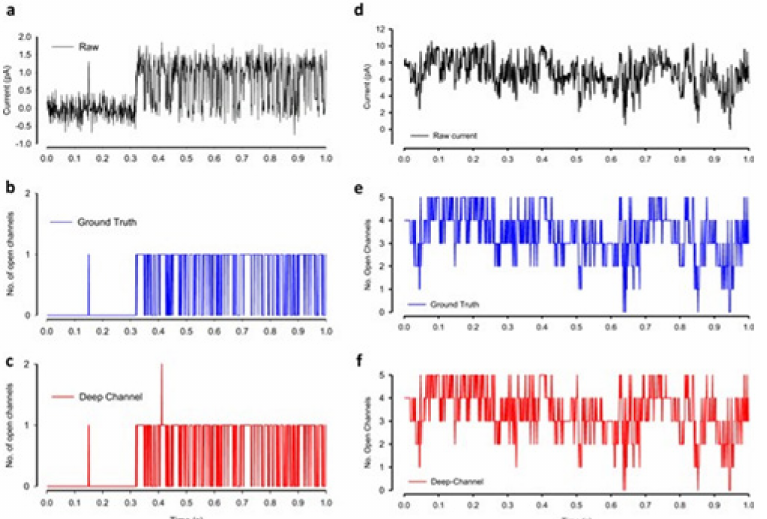
Figure 13. The qualitative performance of the Deep-Channel with (previously) unseen data. ( a – c ) represent examples of Deep-Channel classification performance with ion channels having low activity (data from model M1, Figure 13a,b): ( a ) raw semi-simulated data of the channel event (in black). ( b ) ground truth idealisation/annotation labels (in blue) from the raw data in ( a ). ( c ) Deep-Channel predictions (in red) for the raw data ( a ). ( d – f ) representative examples of Deep-Channel classification performance with five ion channel openings simultaneously (datafrom model M2, Figure 13c,d). ( d ) semi-simulated raw channel events data (black). ( e ) ground truth idealisation/annotation labels (in blue) using raw data in ( d ). ( f ) the Deep-Channel label predictions (in red) for raw data ( d